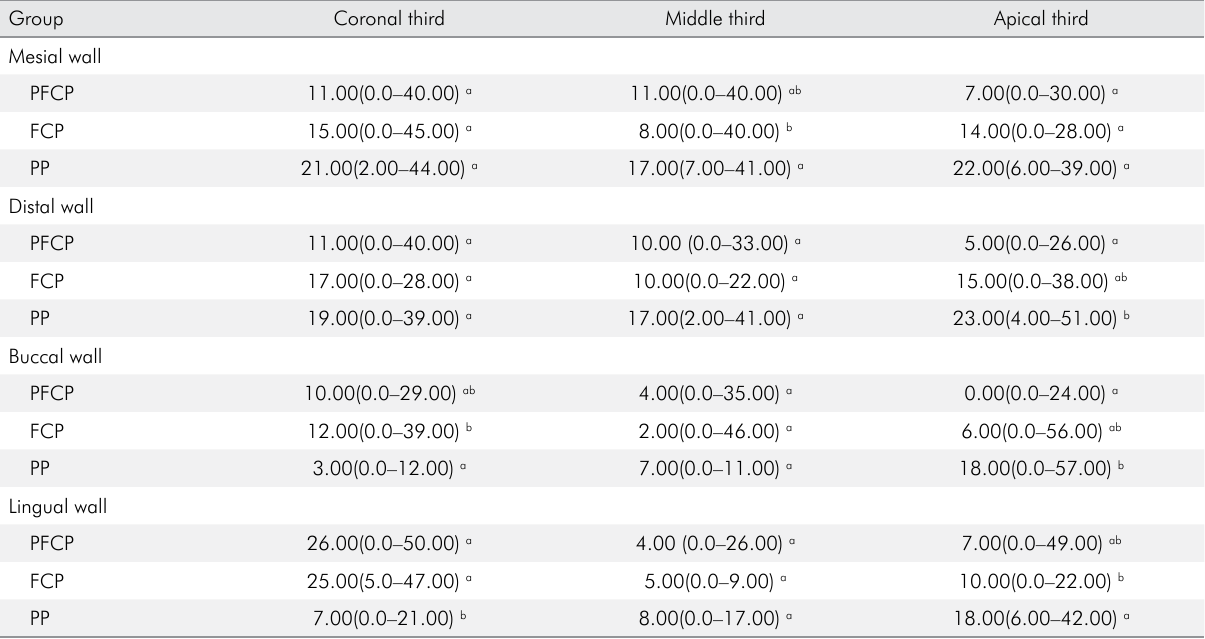
Table 2. Percentage values of dentin removal at each third and on each wall of the root canal (median,